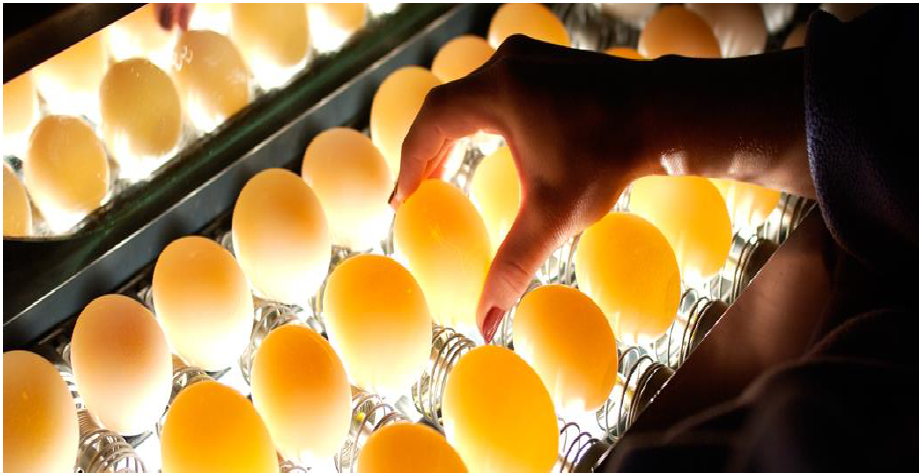
Figure 7. Traditional candling operation.